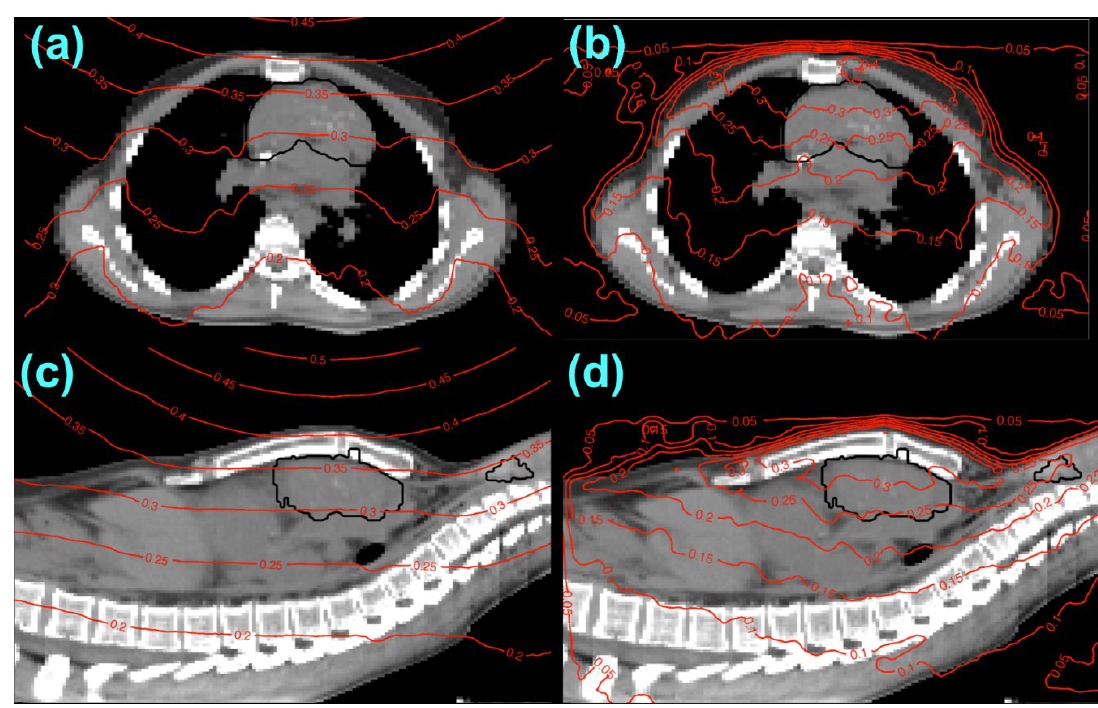
Figure 3. Axial ( a ) and ( b ) and sagittal ( c ) and ( d ) planes of equivalent neutron dose overlaying CT images of the HL patient, with dose calculated using the analytical H/D model ( a ) and ( c ) and the Monte Carlo H/D model ( b ) and ( d ). Equivalent dose values are percentages of the prescribed target dose. The mediastinal target volume and thyroid are indicated by black contours.